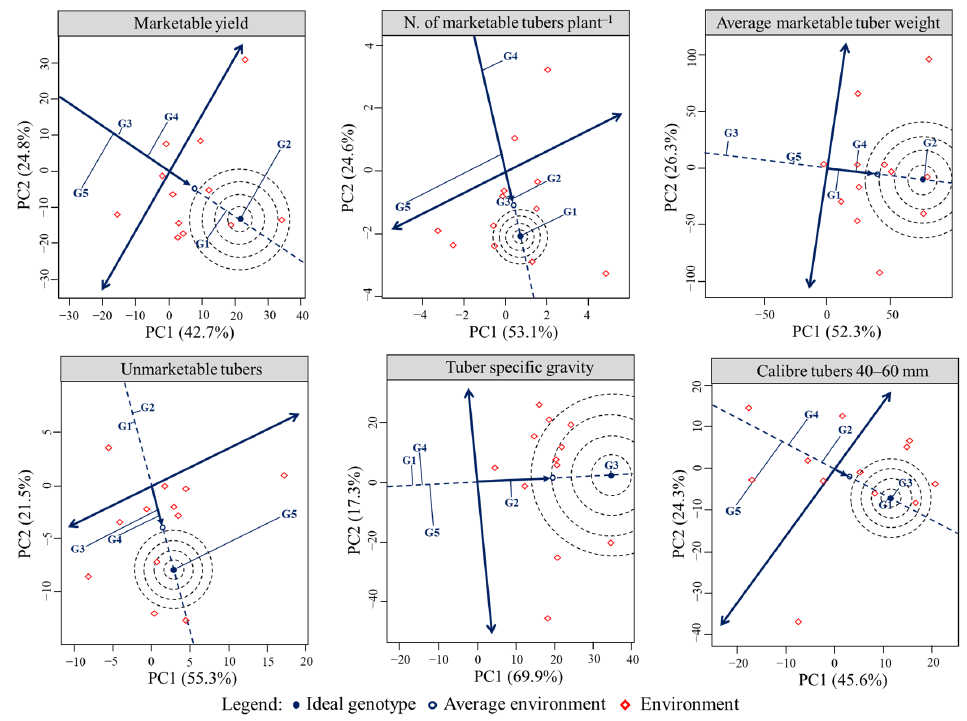
Figure 5. ‘Ranking genotypes’ GGE biplots illustrating the performance of five potato genotypes (G) over 12 environments (E) in comparison to an ideal genotype. The biplots were constructed with scaling = 0, centering = 2, and SVP = 2. G1: Arizona; G2: Generosa; G3: Levante; G4: Paradiso; G5: Vogue; E1–E4: Acireale (seasons I to IV); E5–E8: Giarre (seasons I to IV); E9–E12: Mascali (seasons I to IV).